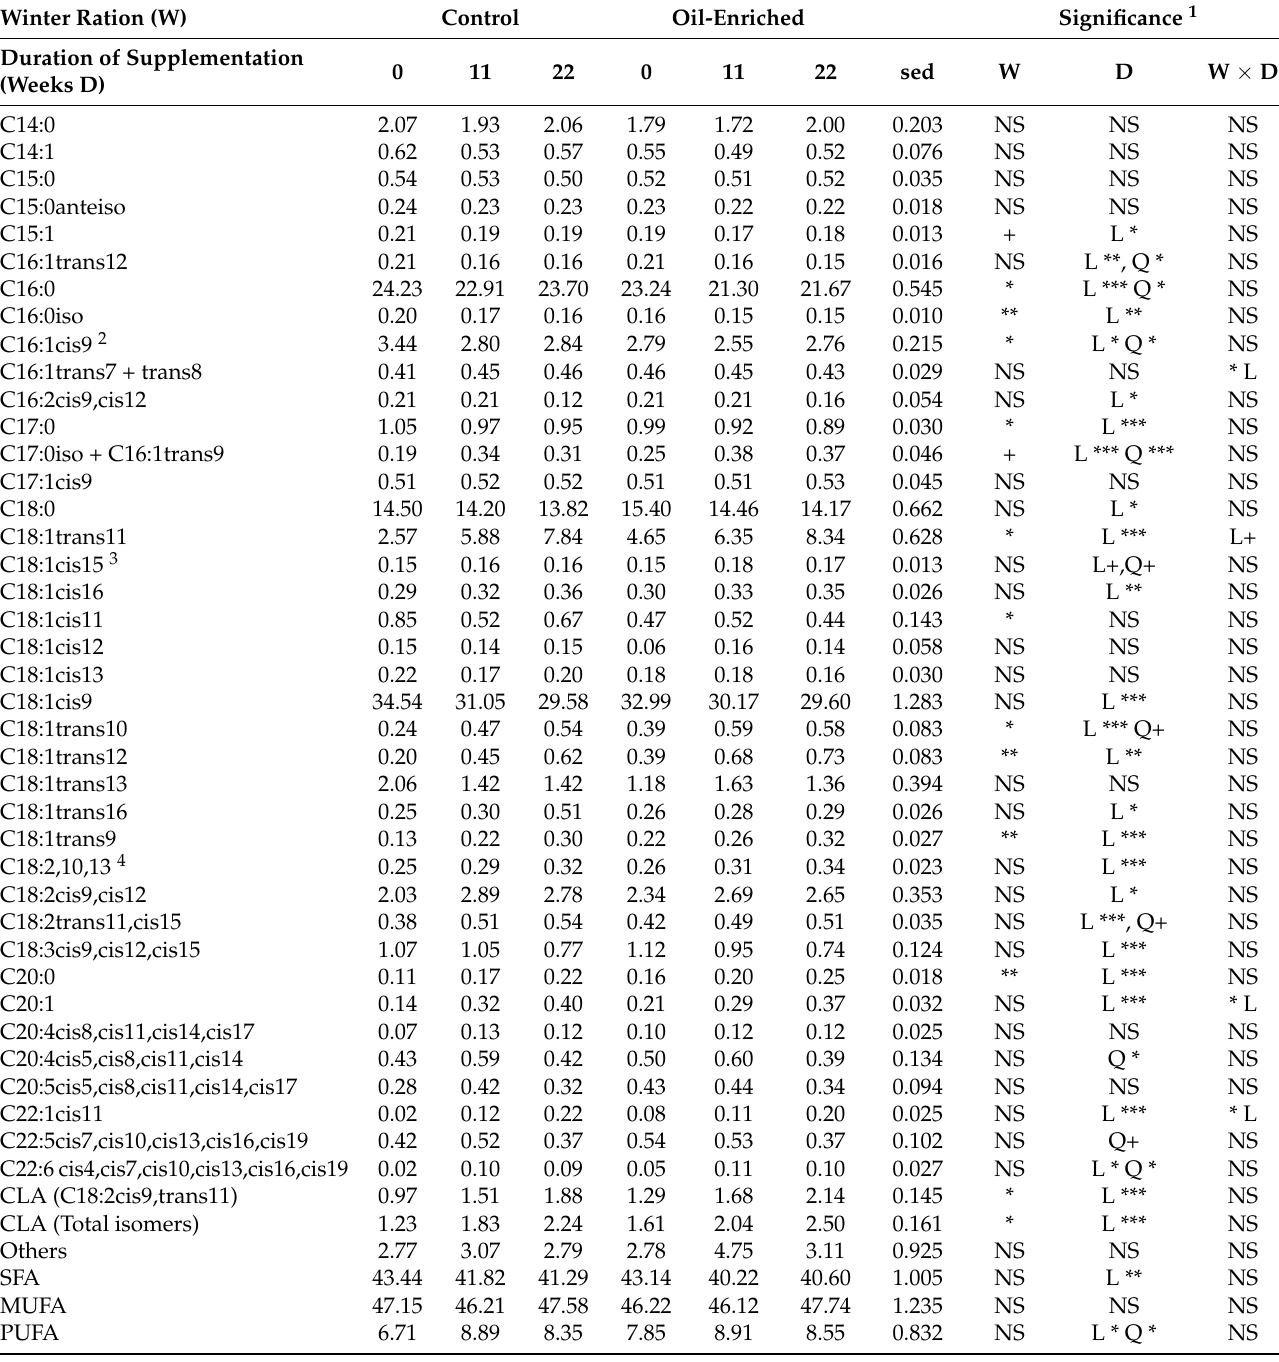
Table 5. The proportion of fatty acids (g/100 g fatty acids) in longissimus muscle of beef